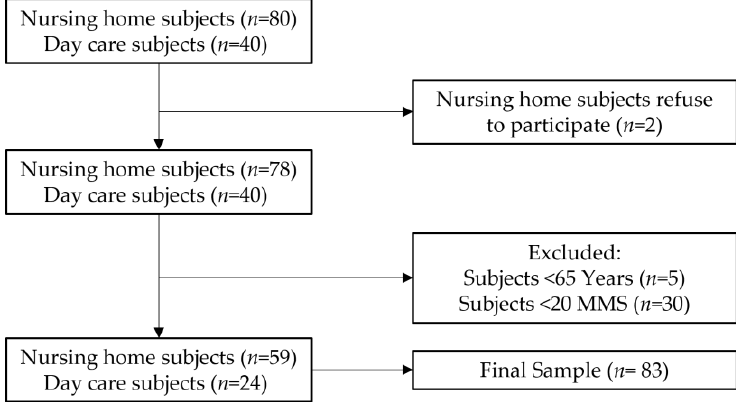
Figure 1. Sample flowchart of the cross-sectional study.